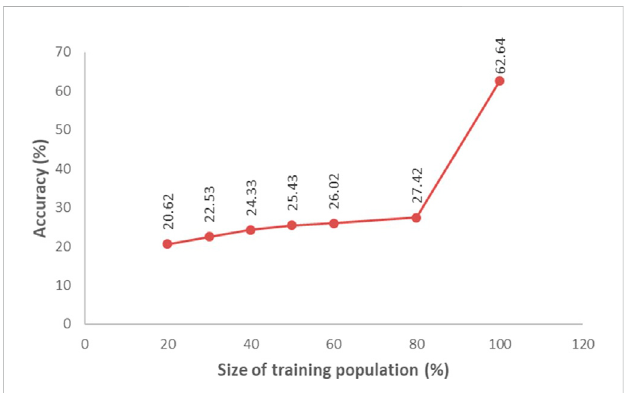
FIGURE 4 Meanpredictionaccuracyforyieldinrelationtotrainingpopulation size determined from a population of 669 breeding lines tested in Boro season at multi-locations during 2020. Average accuracy was determined from 500 iterations of cross-validation of different sizes (proportion of the breeding population) of the training